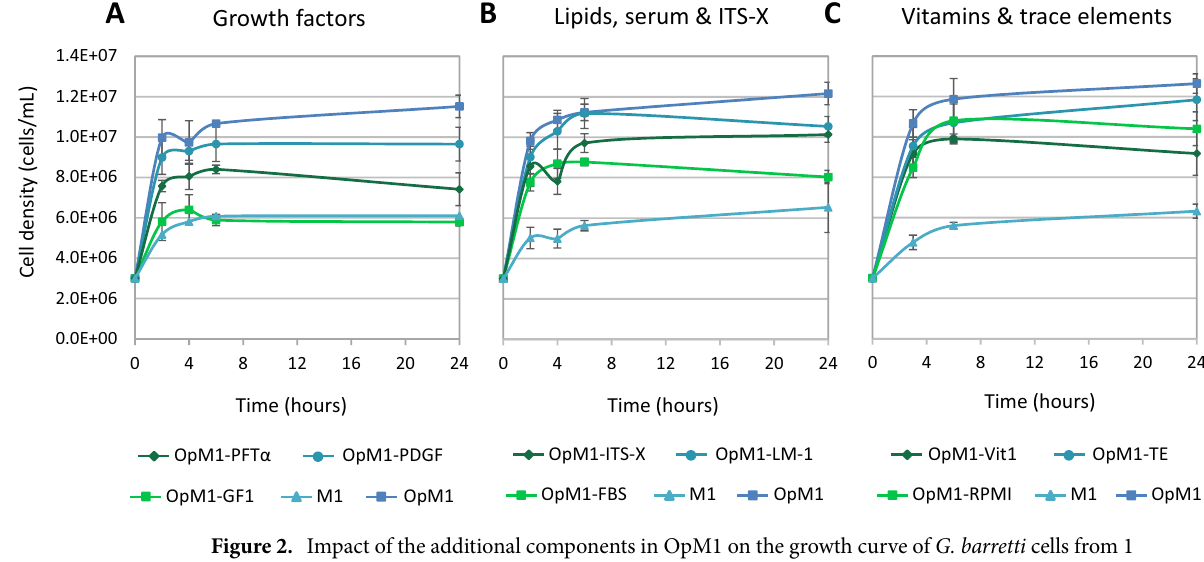
Figure 2. Impact of the additional components in OpM1 on the growth curve of G. barretti cells from 1 individual. Cells were cultured in different OpM1 media compositions, in each of which one component was replaced by sterile dH 2 O. ( A ) OpM1-PFTα, -PDGF, or -GF1, ( B ) OpM1- ITS-X, -LM-1 or -FBS, ( C ) OpM1- Vit1, -TE or -RPMI. OpM1 and M1 were used as controls. Error bars indicate the standard deviation from the average of technical replicates (n = 3).